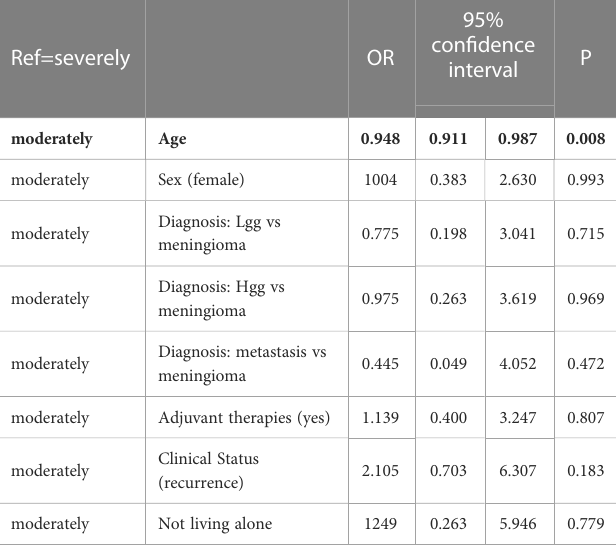
Bold data represent signi fi cant results (p < 0.05). TABLE 4 Variables associated with Worry about tumour- Results of multinomial regression analysis. Ref